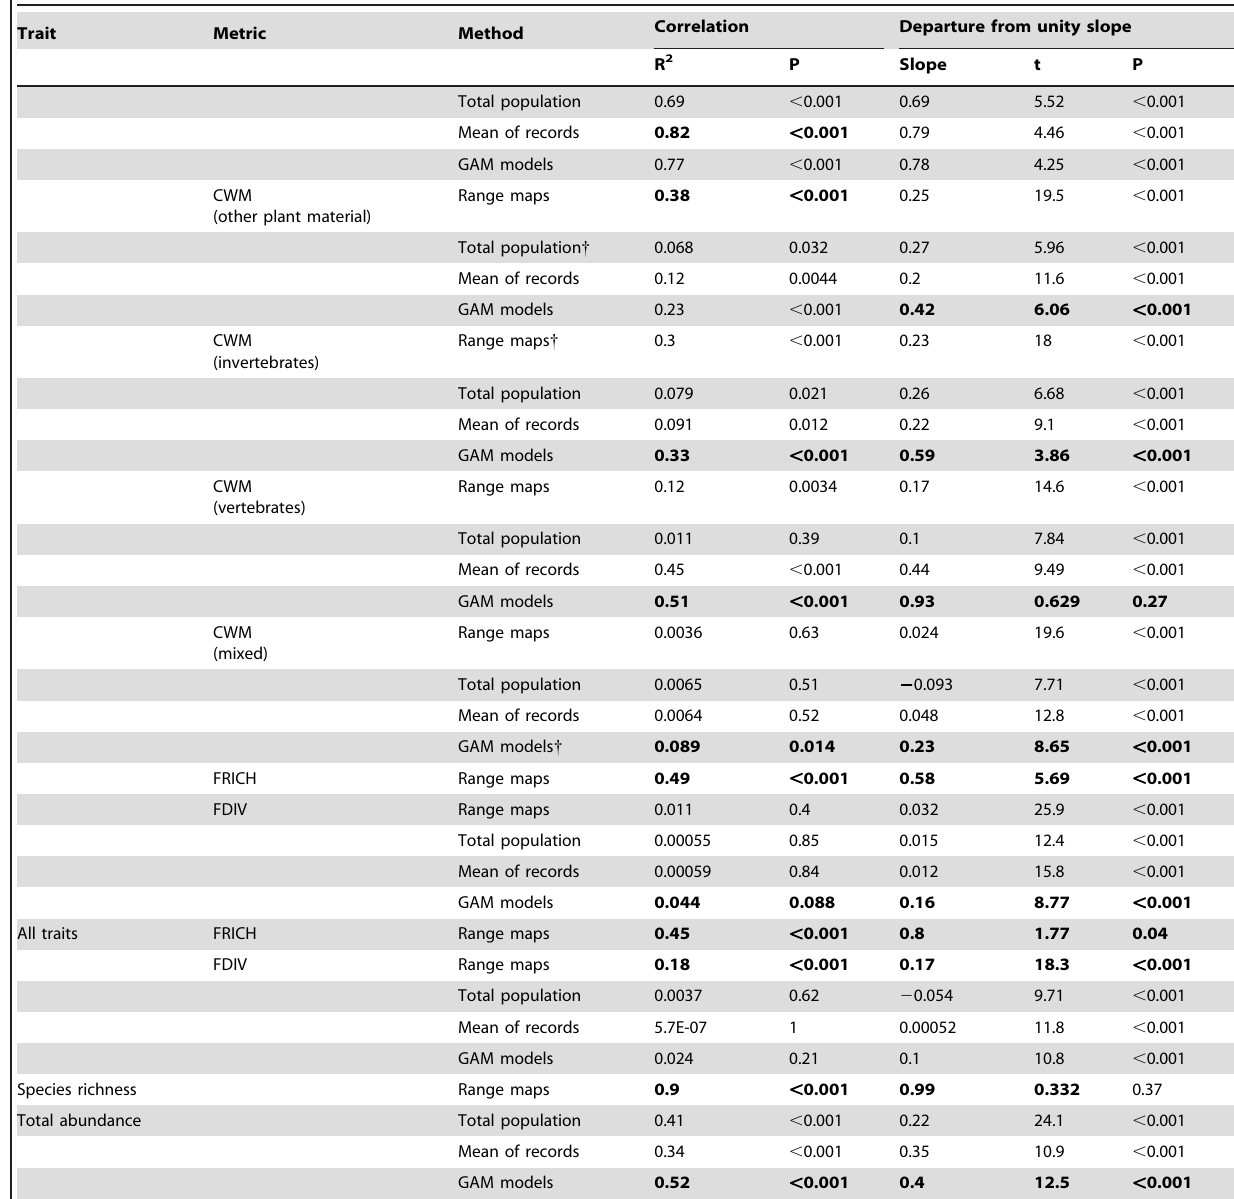
Trait Metric Method